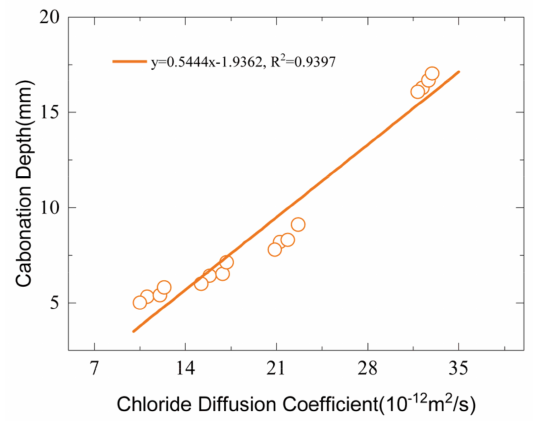
Figure 6. Relationship between carbonization depth and chloride diffusion coefficient.